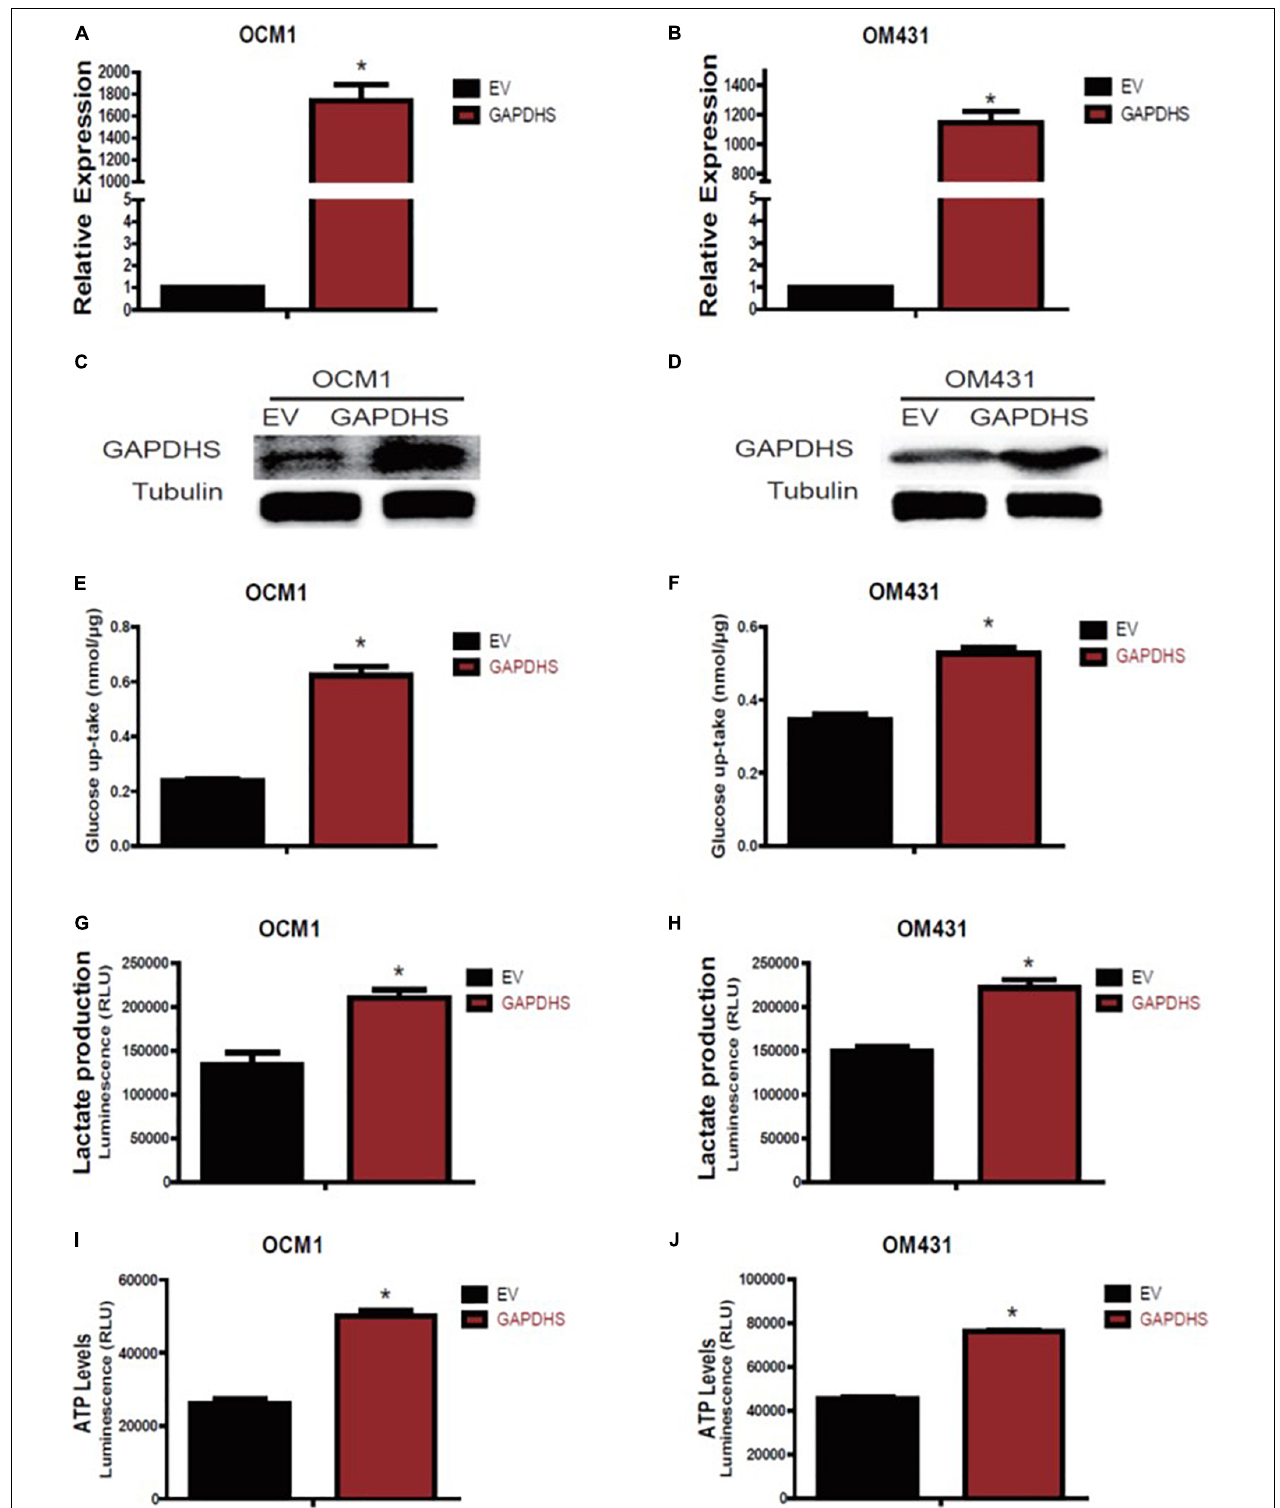
FIGURE 3 | Glyceraldehyde-3-phosphate dehydrogenase (GAPDHS) overexpression promotes glycolysis in melanoma cell lines. (A,B) GAPDHS mRNA levels were determined by real-time PCR in OCM1 and OM431 cells stably overexpressing empty vector (EV) or GAPDHS. (C,D) GAPDHS protein levels were determined by western blotting in OCM1 and OM431 cells stably overexpressing EV or GAPDHS. Tubulin served as the loading control. (E–J) Glucose uptake (E,F) , lactate production (G,H) , and ATP levels (I,J) were measured in OCM1 and OM431 cells stably overexpressing EV or GAPDHS. Data are presented as the mean ± SE. * P < 0.05 compared with the EV